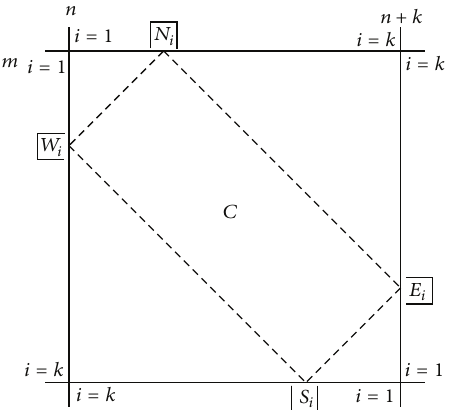
Figure 6: Location of Pad´e approximants around the block in the Cordellier